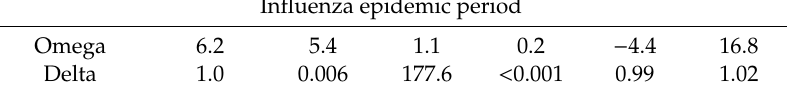
Table 1. Time series analysis Interrupted autoregressive integrated moving average (ARIMA) models for influenza epidemic, COVID-19 epidemic, and containment periods.